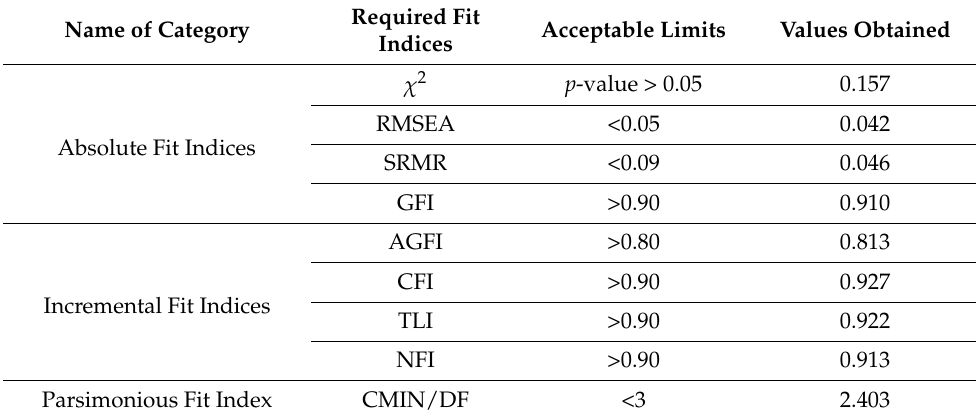
Table 3. Model Fit Analysis.